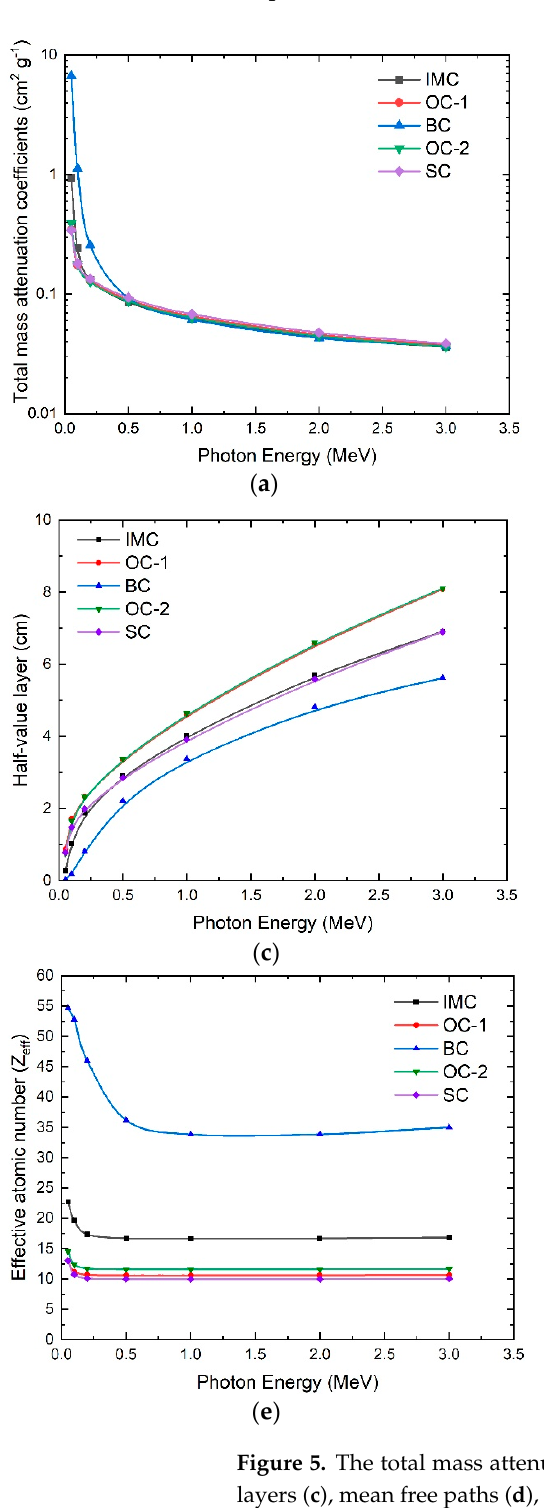
( b ) Figure 4. The a tt enuation of X-rays in the investigated concrete materials using Equation (5) at X- ray energies of ( a ) 0.2 MeV and ( b ) 1 MeV. The thickness of the shielding concrete needed to a tt enuate the photons to 1/100 from the initial value was calculated from the data in Figure 4. It was found that 23, 26, 27, 31, and 32 cm are needed to a tt enuate the 1 MeV X-ray intensity to 1/100 of its incident inten- sity for BC, SC, IMC, OC-1, and OC-2, respectively. In addition, 6, 13, 14, 16, and 17 cm are needed to a tt enuate a 0.2 MeV X-ray fl ux to an intensity 1/100 of its initial intensity of the BC, SC, IMC, OC-1, and OC-2, respectively. At the 3 MeV X-ray energy, the thicknesses needed to a tt enuate to 1/100 for BC, SC, IMC, OC-1, and OC-2 are 38, 46, 47, 54, and 55 cm, respectively. Accordingly, we could conclude that barite concrete is the most e ff ective